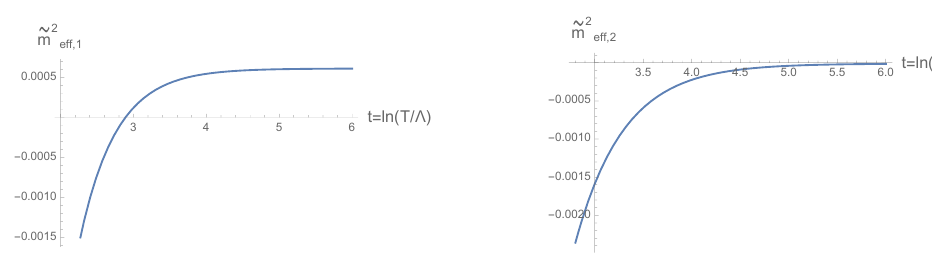
Figure 10. Plots of the rescaled effective masses (squared) against t = ln( T/ Λ) for r = 0 . 03 , θ = 4 . 52 , λ = 0 . 001 , c 1 = − 0 . 1 , c 2 = 0 : both regime, and their magnitudes grow as the temperature is decreased. In the high temperature limit, saturates at a positive value while m 2 e eff , 1 baryon symmetry in the second sector remains broken at all temperatures where the perturbative analysis can be trusted, while the baryon symmetry in the first sector is restored at a critical temperature. This critical temperature ( T